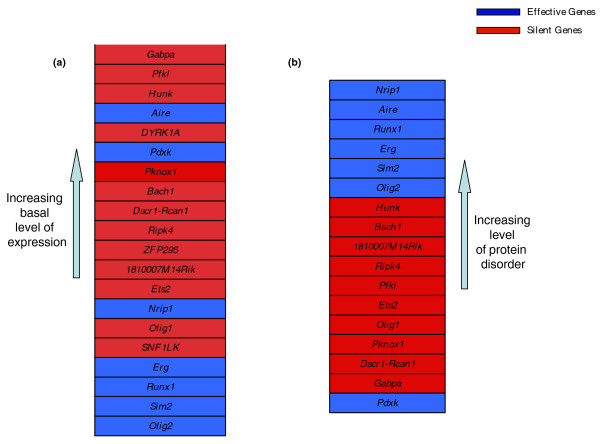
The basal expression level and dosage sensitivity of HSA21 genes in mES cells. The effective genes are highlighted in blue, and the silent genes in red. (a) Selected HSA21 genes sorted according to their average expression level in mES cells, from the most (gene rank = 1) to the least expressed. (b) Selected HSA21 genes sorted according to the total length of the 'disordered' region of the encoded protein (measured with the GlobPlot tool).